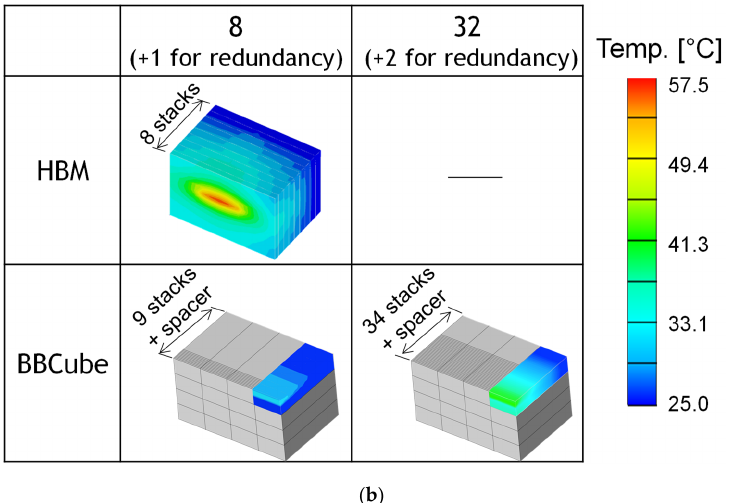
Figure 35. Thermal simulation results: ( a ) the temperature difference between the top of the stacked dies, which is set to room temperature, and the highest temperature part of the DRAM cell and ( b ) heat distribution.